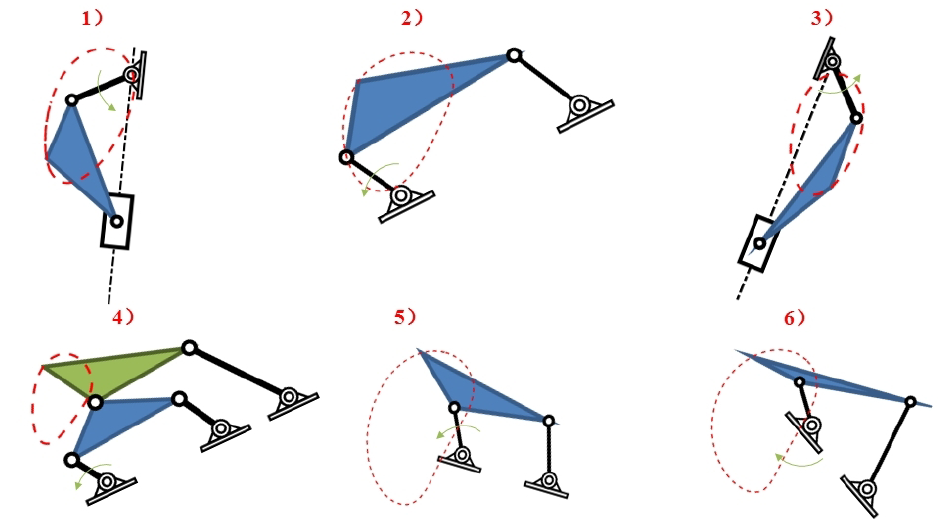
Figure 13. Six linkages with their resultant coupler paths.